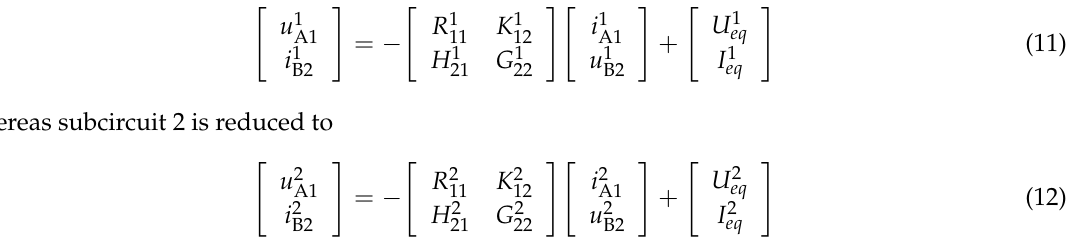
are selected as the independent input variables.